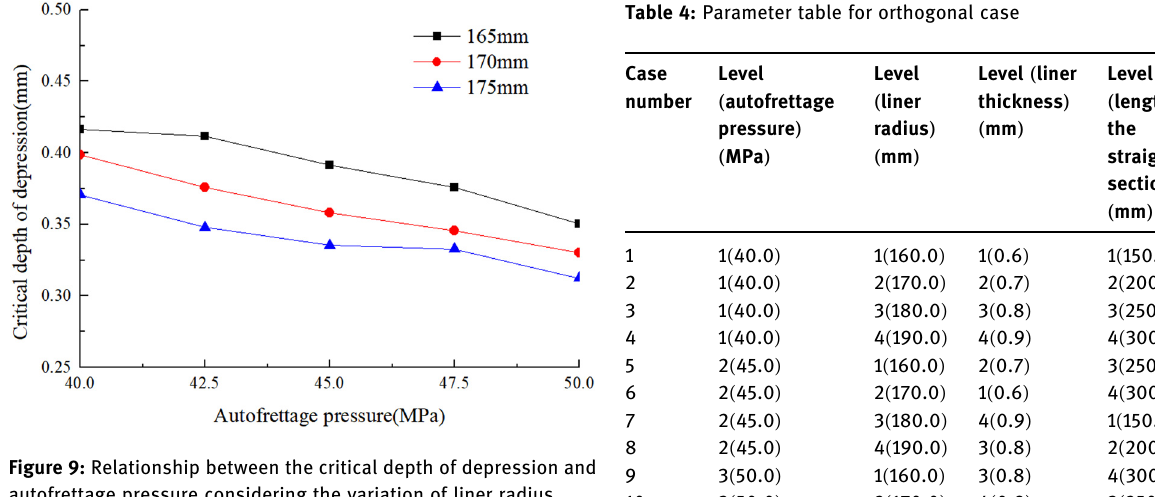
Table 4: Parameter table for orthogonal